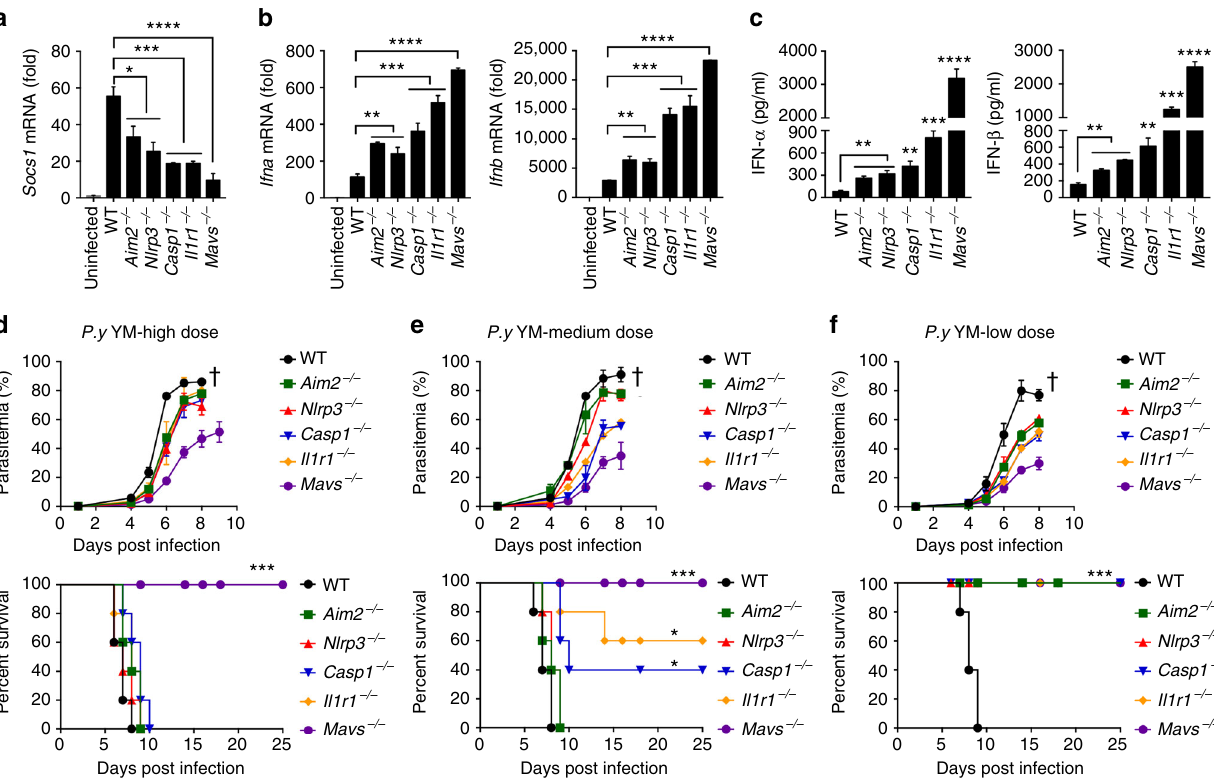
Fig. 7 Fine-tuned regulation of SOCS1 induction by in fl ammasome and type I IFN signaling dictates host resistance to YM infection. a – c WT and de fi cient ( Aim2 − / − , Nlrp3 − / − , Casp1 − / − , Il1r1 − / − , and Mavs − / − ) mice ( n = 5) were infected with YM, RNA from pDCs was isolated at 18 h post infection and used for expression analysis of Socs1 ( a ), Ifna and Ifnb ( b ) by using qPCR, and serum levels of IFN- α and IFN- β in WT and de fi cient mice at 24 h after P. yoelii YM infection are shown in c . d – f WT and de fi cient ( Aim2 − / − , Nlrp3 − / − , Casp1 − / − , Il1r1 − / − , and Mavs − / − ) mice ( n = 5) were infected with high dose (1 × 10 6 iRBCs, d ), medium dose (0.75 × 10 6 iRBCs, e ) or low dose (0.5 × 10 6 iRBCs, f ) of P. yoelii YM. Daily parasitemias and mortality rates of WT and de fi cient mice after P. yoelii YM infection are shown. Data are plotted as mean ± SD and representative of three independent experiments with similar results. * p < 0.05, ** p < 0.01, *** p < 0.001 vs. corresponding control. NS, not signi fi cant. Dagger denotes mouse